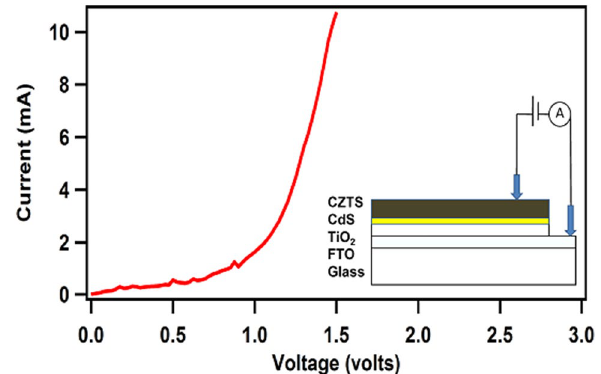
Fig. 5 Schematics and dark V–I characteristics of CZTS/CdS/TiO FTO P–N